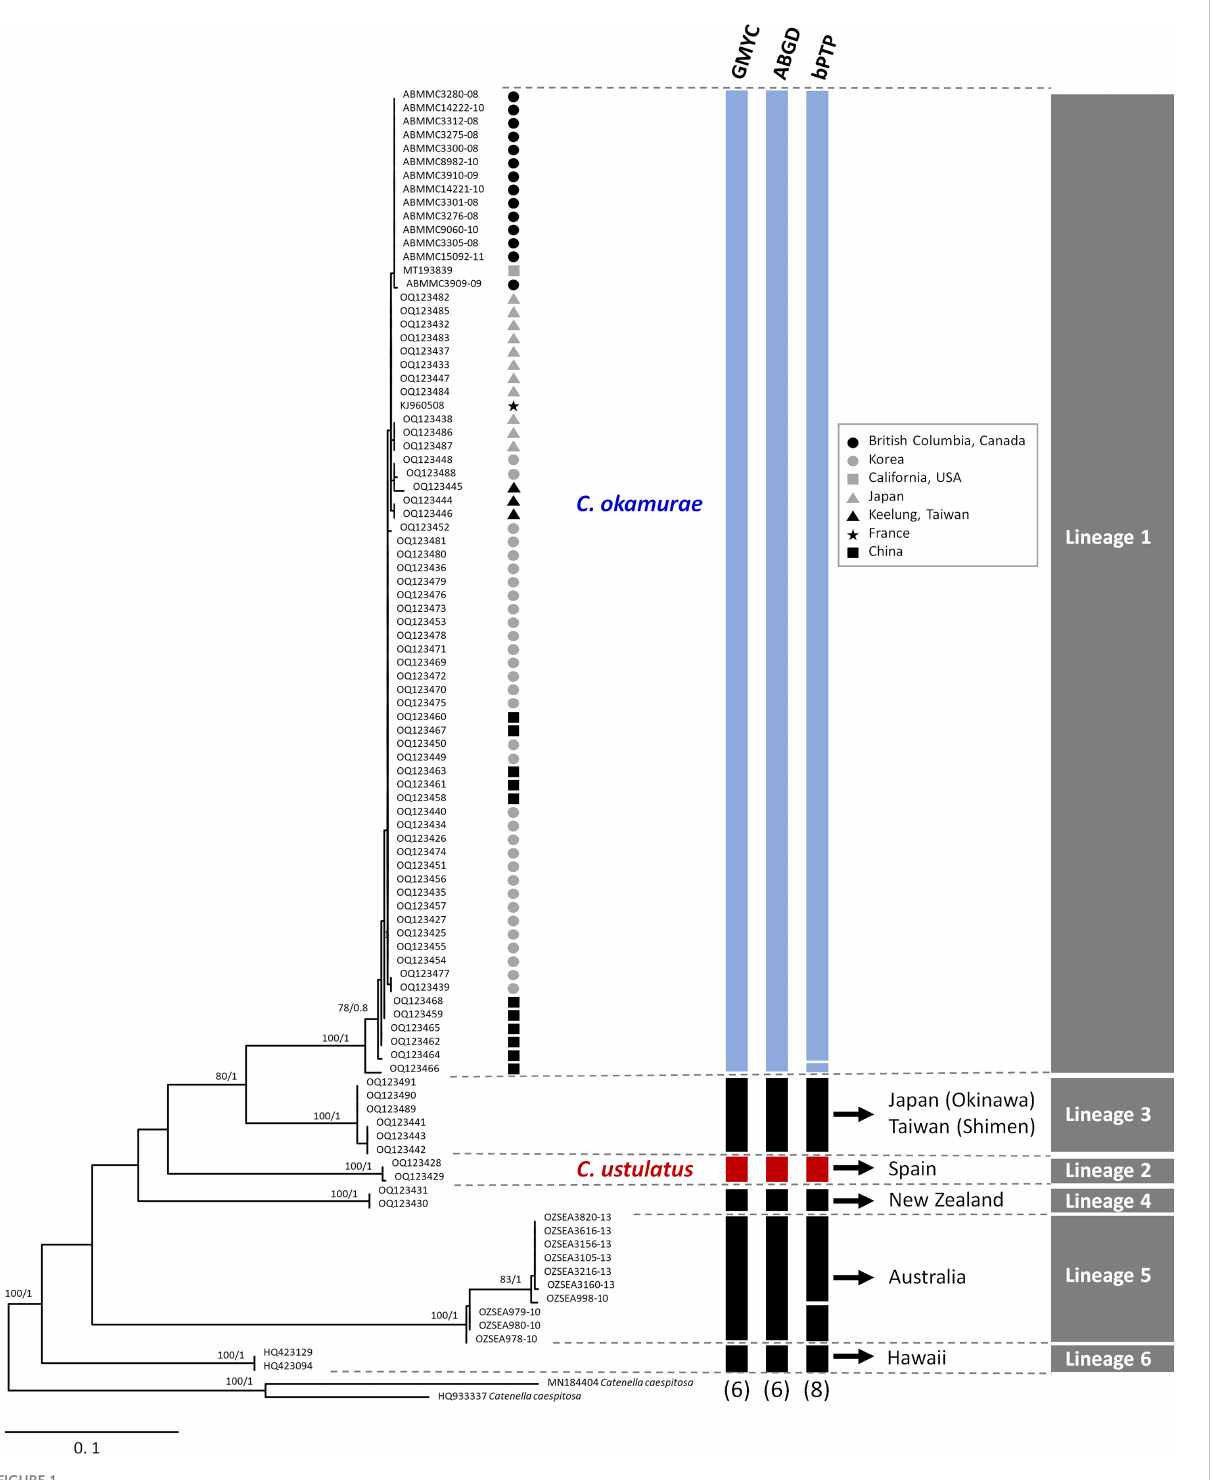
FIGURE 1 Maximum likelihood phylogeny of the genus Caulacanthus based on the COI-5P gene. ML bootstrap values (left) and Bayesian posterior probabilities (right) are indicated at the nodes. Values of <50% ML bootstrap and <0.8 posterior probabilities are not shown. The results of three species delimitation methods (GMYC, ABGD, and bPTP) for COI-5P gene are shown in the columns at the edge of the tree, with the number of putative species depicted at the bottom. Blue and red columns indicate Caulacanthus okamurae and C. ustulatus , respectively. Black columns indicate other lineages of Caulacanthus . Gray columns on right edge summarize the results for the tested species delimitation